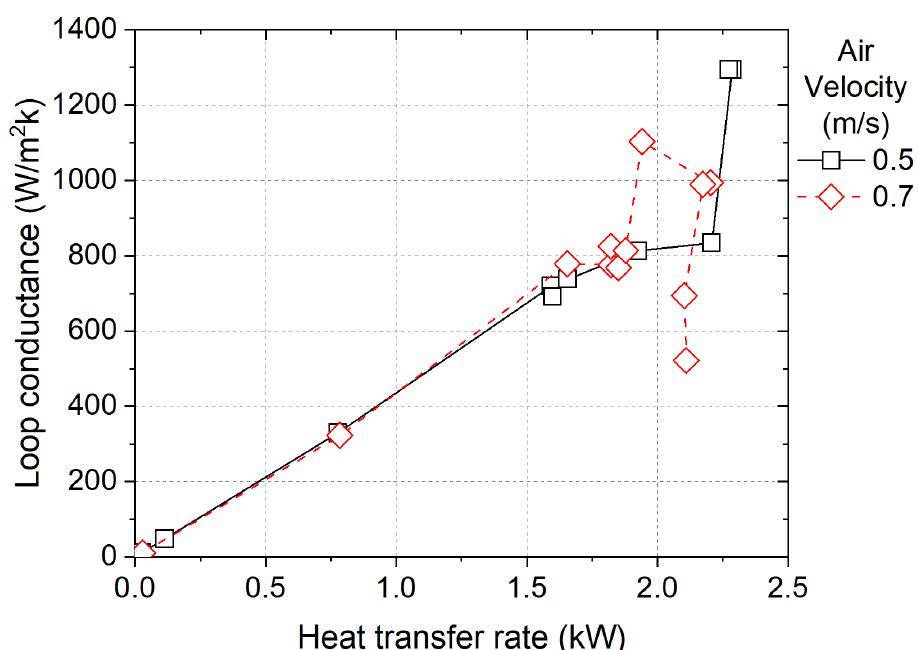
Figure 10. Estimated loop conductance of an FHP.